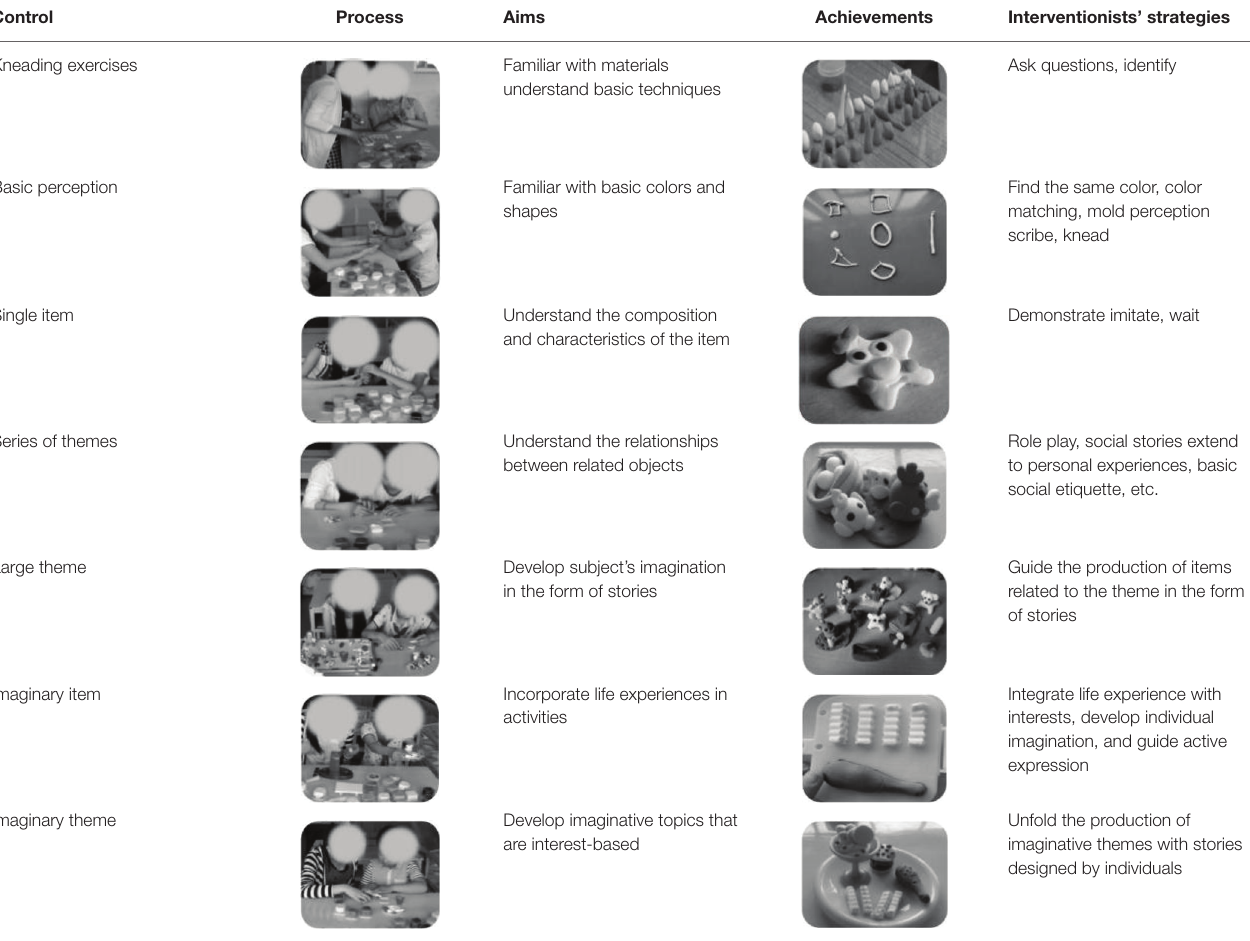
TABLE 2 | Intervention contents and interventionists’ strategies (Study